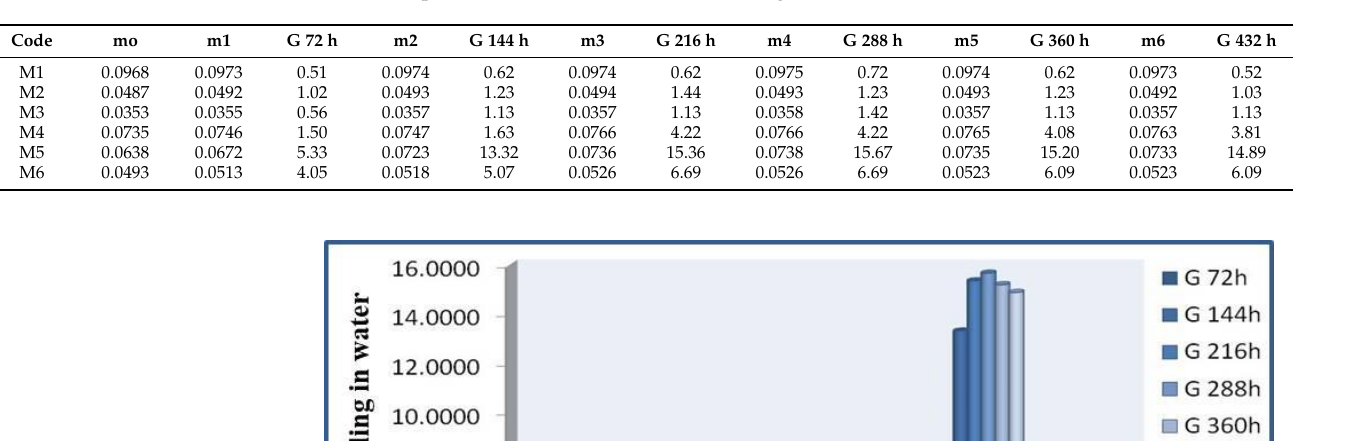
Table 2. Experimental results for water swelling of materials M1–M6.